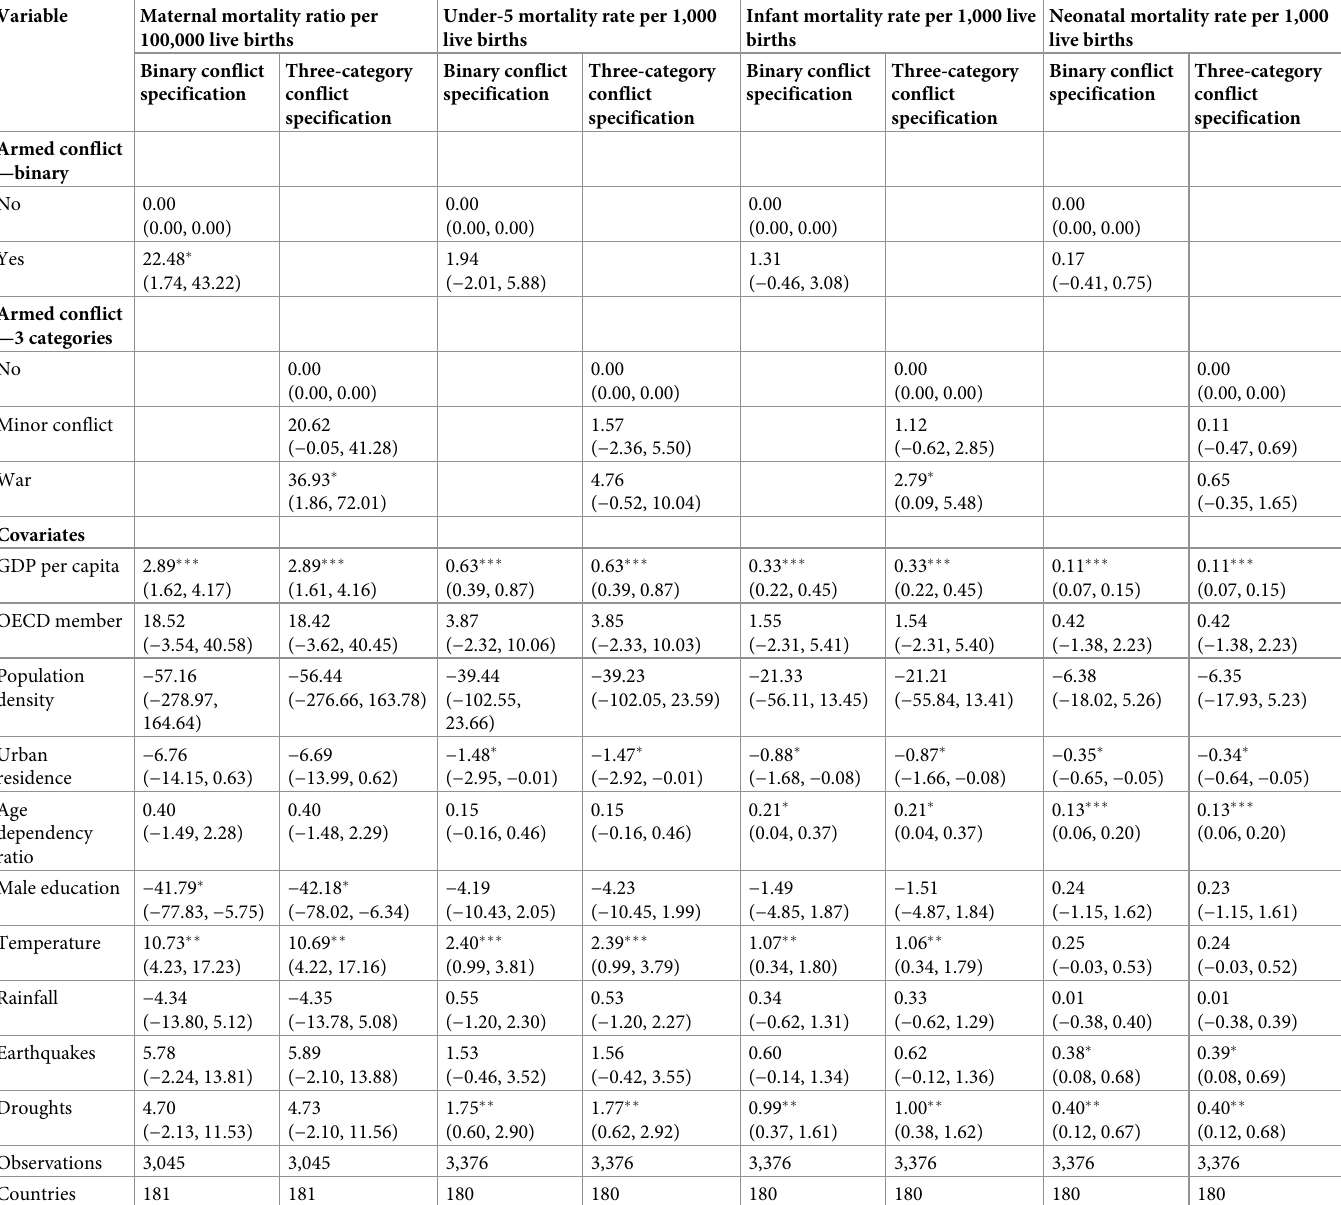
Table 2. AU : Iaddedcolumnsubheadstodifferentiate = describethe 2 columnsundereachoutcome : Ialsopulledtheinformationonnumberofobservationsandnumberofcountriesfromthebottomofthetableintothecolumnheads : Pleasecheckthattheseeditsarecorrect : The association between armed conflict and maternal and child mortality (adjusted beta coefficients, 95% confidence intervals).